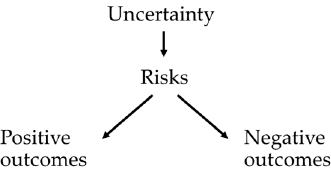
Figure 1. Relationships among uncertainty, risks and outcomes. Adapted from [25].